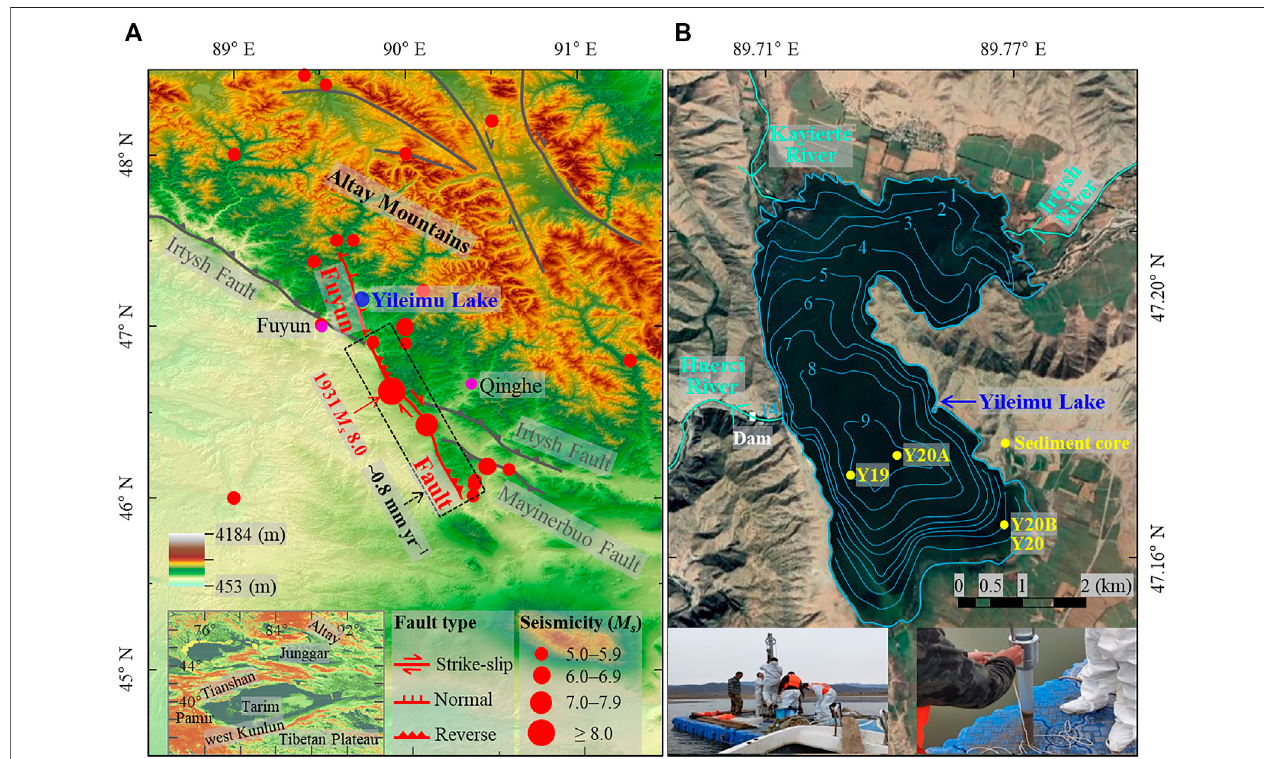
FIGURE 1 | (A) Locations and characteristics of the Fuyun Fault, Yileimu Lake, and historical earthquakes around the fault. The average strike-slip rate was ~0.8 mm year − 1 inthelatePleistocene(Baietal.,1996;Xuetal.,2012).Faultandearthquakedatawere fi rstpublishedbyFanetal.(2020b).DigitalElevationModel(DEM)isfromhttp:// www.gscloud.cn/. (B)